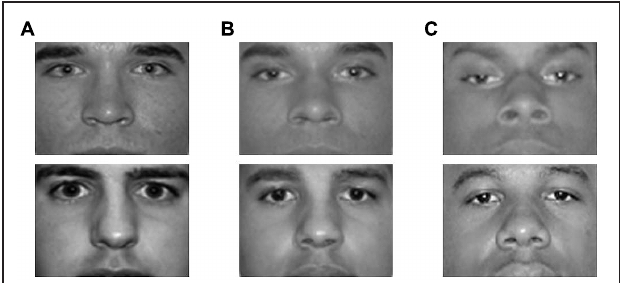
FIGURE 4 | Sample photographs from Study 3. Stimuli used in this study included 3 photos of 100% White targets (column A ), 3 digitally created photos of 50% Black/50% White targets (column B ), and 3 photos of 100% Black targets (column C ). Images were cropped to display only the targets’ eyes and noses.